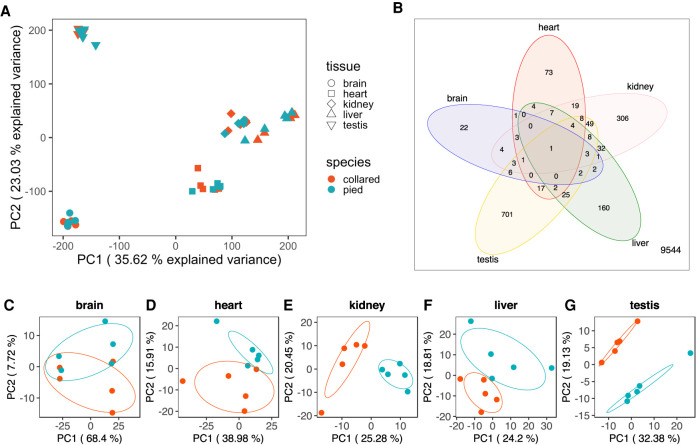
Variation in gene expression across tissues, and within and between species. (A) Principal component analysis (PCA) plot of the first two principal components of variation in gene expression across five different tissues for five collared flycatchers (red) and five pied flycatchers (blue). (B) Venn diagram of differentially expressed genes across the five tissues. Numbers indicate the number of genes in each category. The number of genes not differentially expressed in any of the tissues is provided in the bottom right corner. (C–G) PCA plots of the first two principal components of variation in gene expression separately for the five different tissues. Ellipses indicate the species-specific mean with a range of ±1 standard deviation, in red for collared flycatchers, in blue for pied flycatchers.